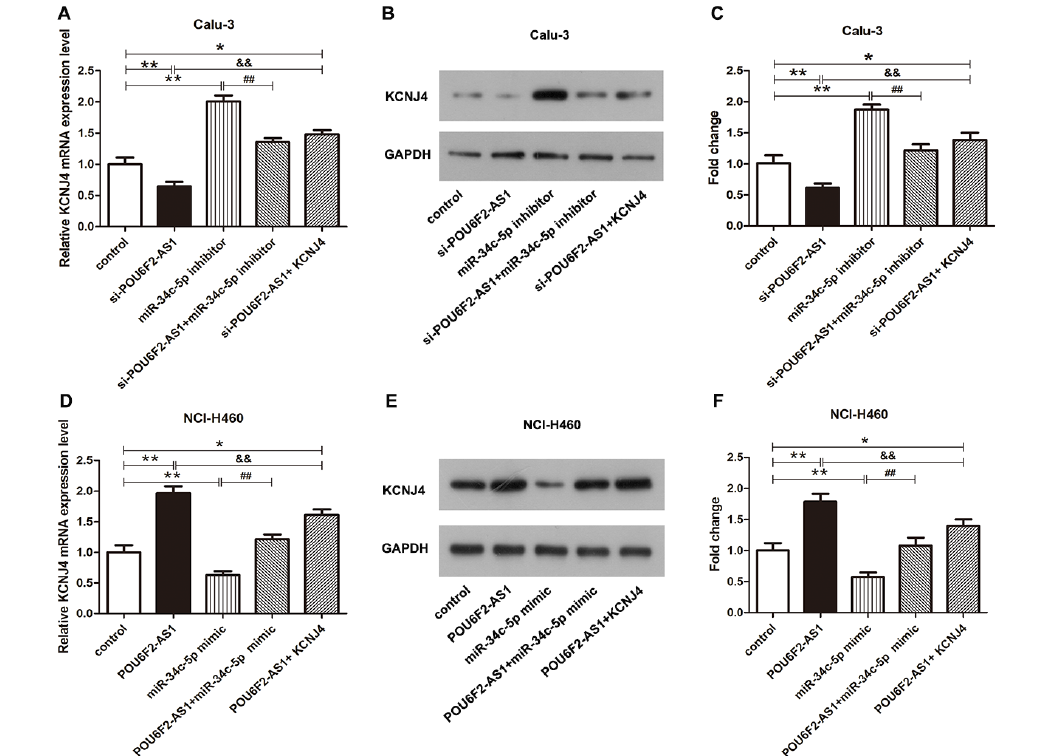
Figure 3 – POU6F2-AS1 served as a ceRNA via sponging miR-34c-5p to elevate KCNJ4. (A) The mRNA and (B) protein expression level of KCNJ4 in Calu-3 cells were demonstrated. (C) The protein expression level of KCNJ4 was quantified. (D) The mRNA and (E) protein expression level of KCNJ4 in NCI-H460 cells were detected. (F) The quantification of (H). *P < 0.05, **P < 0.01, ## P < 0.01 and && P <